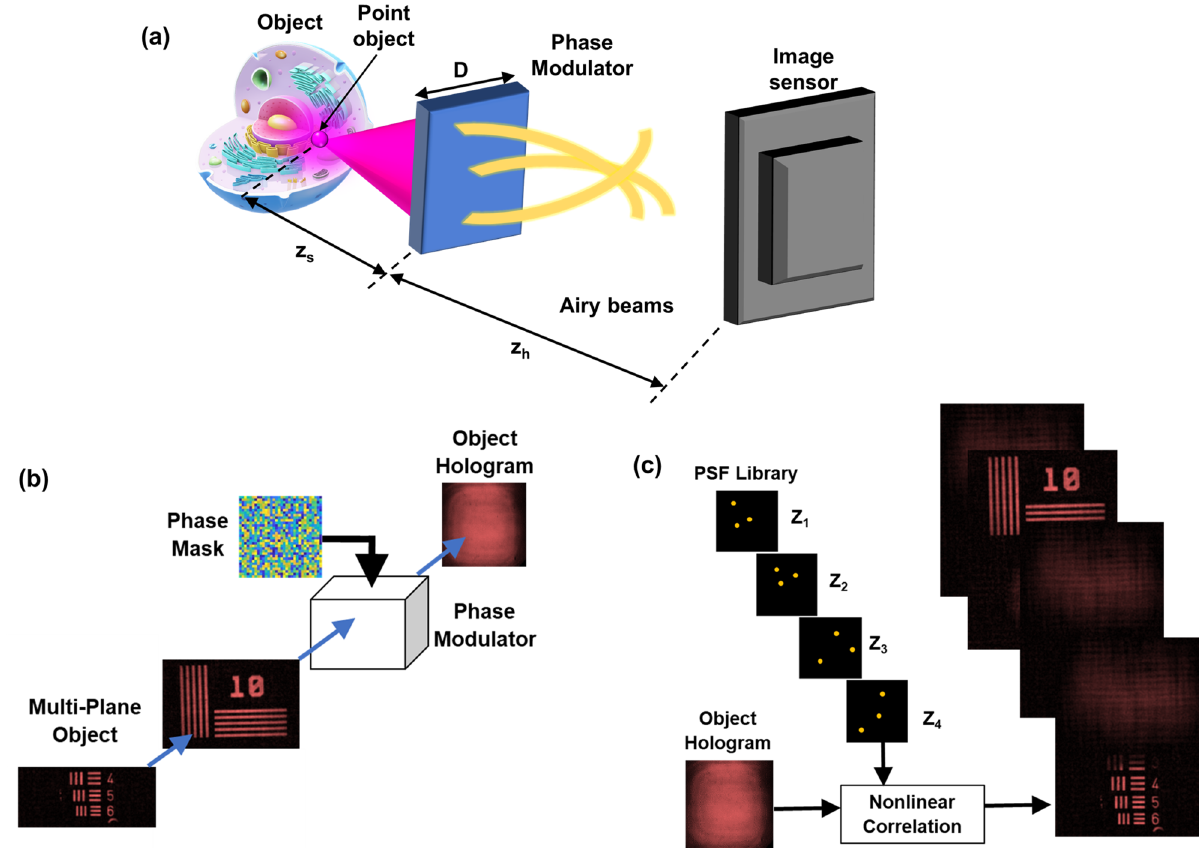
Figure 1. ( a ) Optical scheme of the imaging concept. Light from an object point is converted into a sparse random array of Airy beams. ( b ) Recording procedure: light from a multiplane object is incident on a phase modulator, and the object hologram is recorded. ( c ) Reconstruction procedure: the object hologram is processed with the PSF library reconstructing depth-specific information. The images in ( c ) are generated using MATLAB (version R2020b) 36